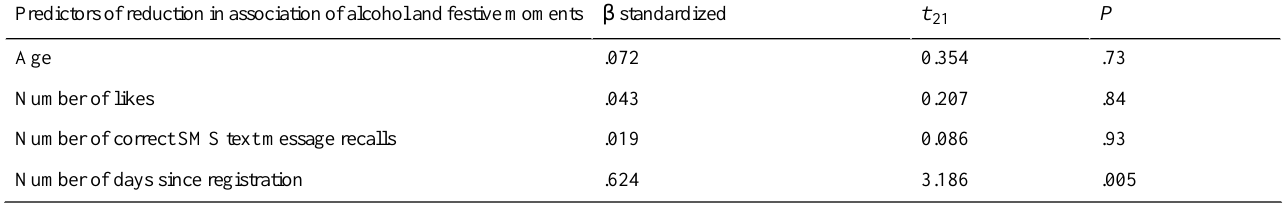
Table 3. Linear regression analyses predicting reduction in association between alcohol and festive moments for participants who have participated at least once, controlling for age, number of Facebook likes, number of SMS text message recalls, and number of days since